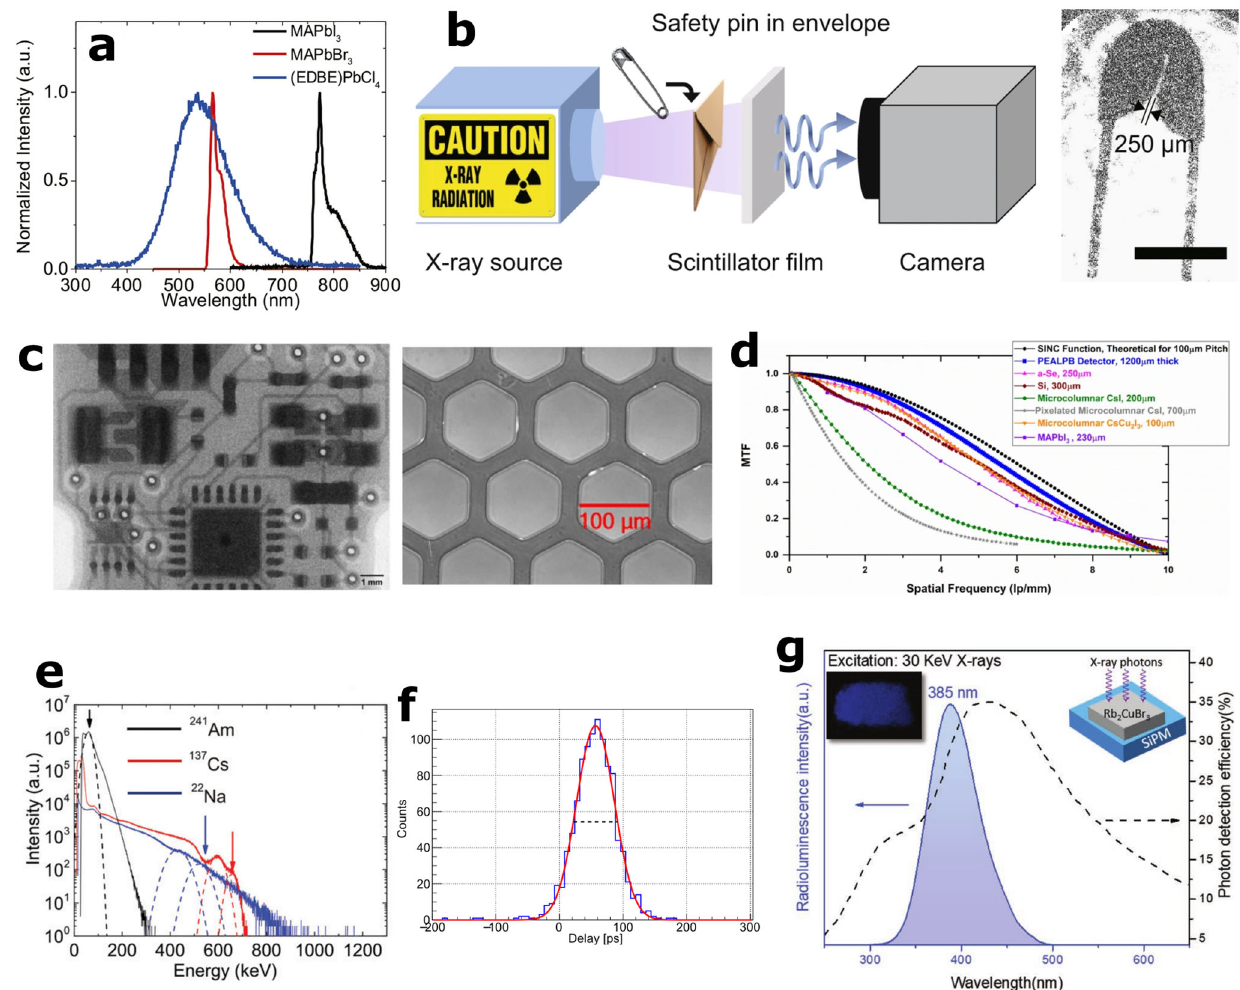
Fig. 1 Development of low-dimensional perovskite crystal scintillators. a Comparison of the normalized X-ray excited luminescence spectra at T = 10 K. b Scheme of X-ray imaging setup using 1:1 Li-(PEA) 2 PbBr 4 as scintillator. The safety pin is inside the envelope and the image is shown in the right side. c X-ray images of a Universal Serial Bus-drive circuit and micropillar plates. d MTF curve of lithium-alloyed phenethylammonium lead bromide detectors along with other state-of-the-art detectors with relatively lower thicknesses. The plot thicknesses are representative of the sensor thickness levels. The sync function plot corresponding to a 100 µ m pixel pitch is also shown for reference. e Pulse height spectra under gamma-ray excitation with different sources for Li-doped (PEA) 2 PbBr 4 and the respective average light yields and average energy resolutions of three measurements for different energies. f Delay distributions at 20 mV of Li-doped (PEA) 2 PbBr 4 . The red solid lines are the Gaussian functions, which fi t the distributions, and the black dotted lines provide the full width half maximum (FWHM) of the distributions. g Radioluminescence spectrum under 30 keV X-ray excitation and wavelength dependent photon detection ef fi ciency of the silicon photomultiplier. The left inset shows the photograph of Rb 2 CuBr 3 crystals under X-ray irradiation and the schematic model at the right shows the test method of measuring emission intensity by silicon photomultiplier. ( a ) adapted with permission from ref. 14 , Copyright Springer-Nature, 2016; ( b ) adapted with permission from ref. 28 , Copyright Springer-Nature, 2020; ( c , d ) adapted with permission